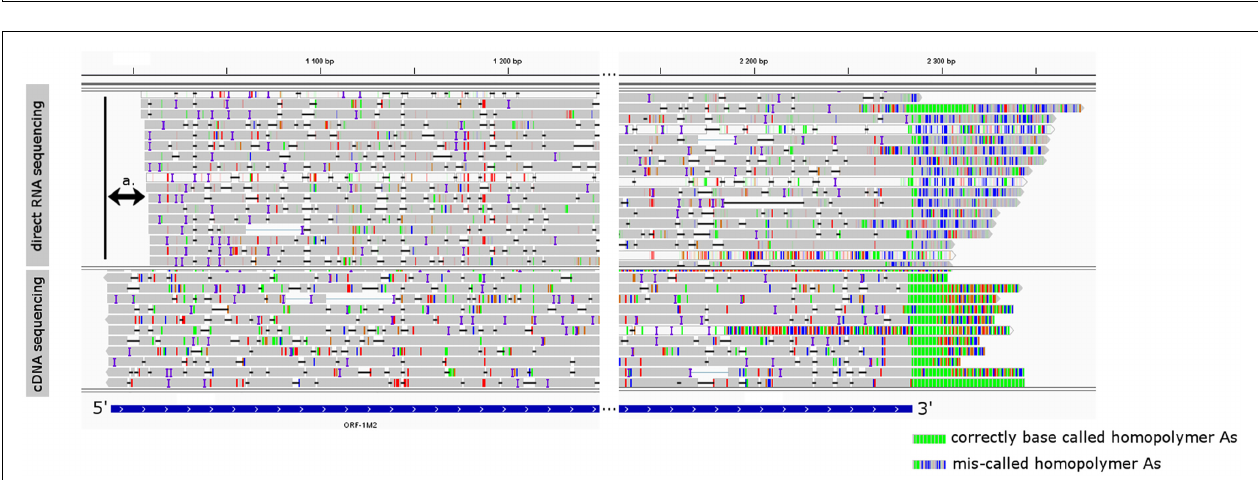
FIGURE 3 | The length distribution of reads for each sequencing method. The number of reads was normalized with the total number of reads for each sequencing platform (red dots: PacBio; blue dots: ONT MinION cDNA; gray dots: ONT MinION direct RNA).